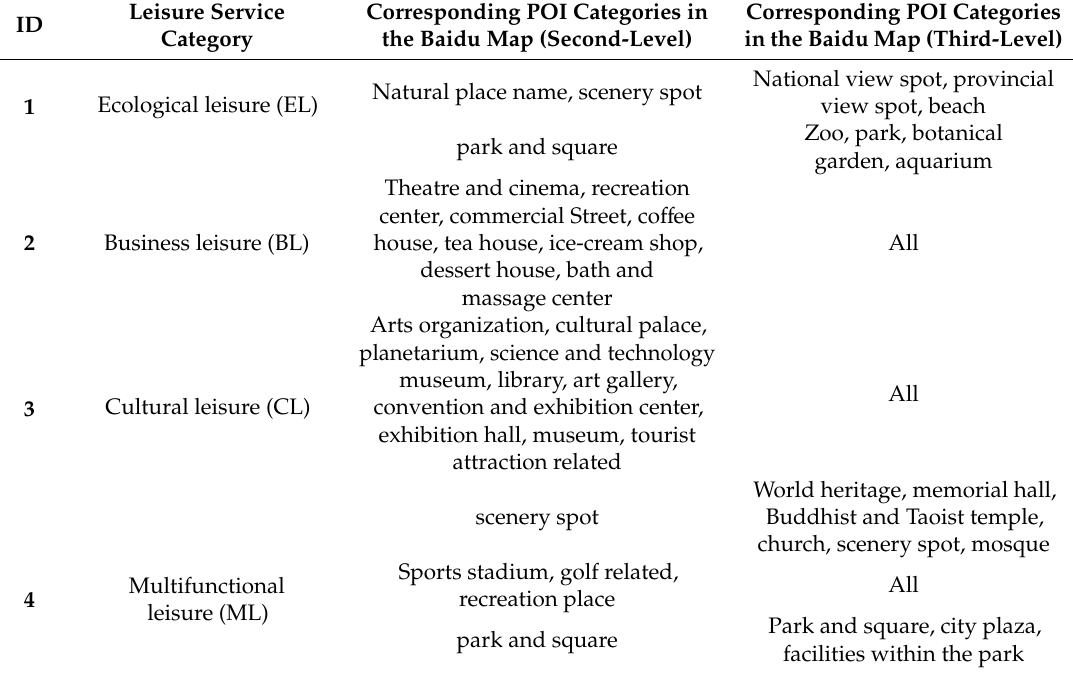
Table 1. Reclassification of leisure